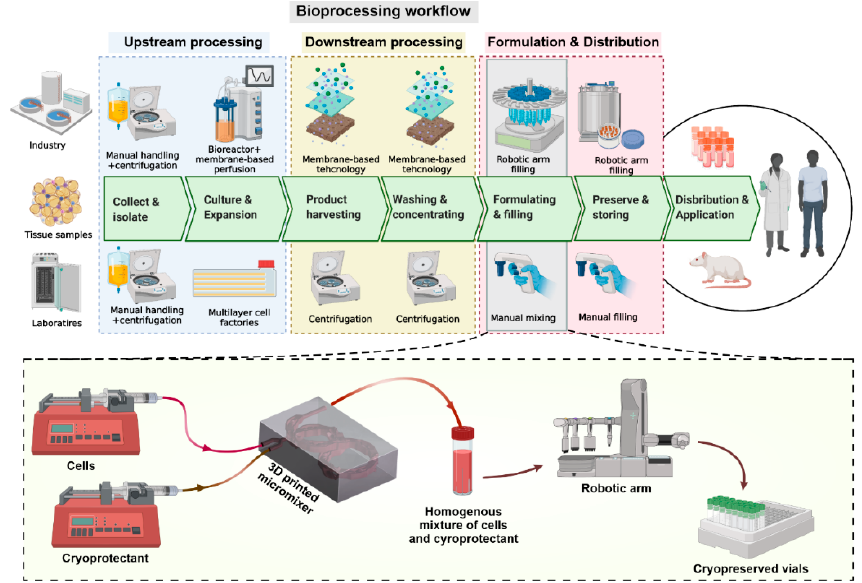
Figure 1. Stem cell production process and the potential application of our proposed micromixer during this process. The micromixer can be either integrated into the current robotic arm system to perform homogenous mixing of stem cells and cryoprotectants or used separately in laboratories to increase the speed of cell–cryoprotectant mixing.